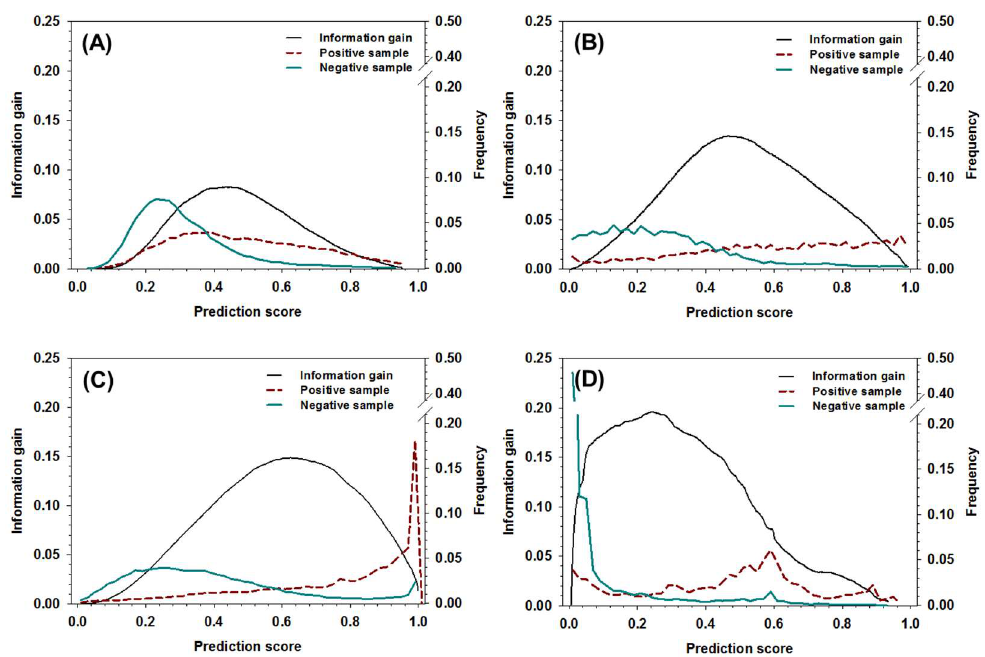
Figure 2. The distribution of information gain, positive sample, and negative samples as a function of prediction score for ( A ) DisEMBL, ( B ) IUPred, ( C ) VSL2, and ( D ) ESpritz. The x -axis shows the prediction score, the y -axis on the left shows the values of information gain, and the y -axis on the right shows the fractions of positive samples and negative samples at different prediction scores, respectively.